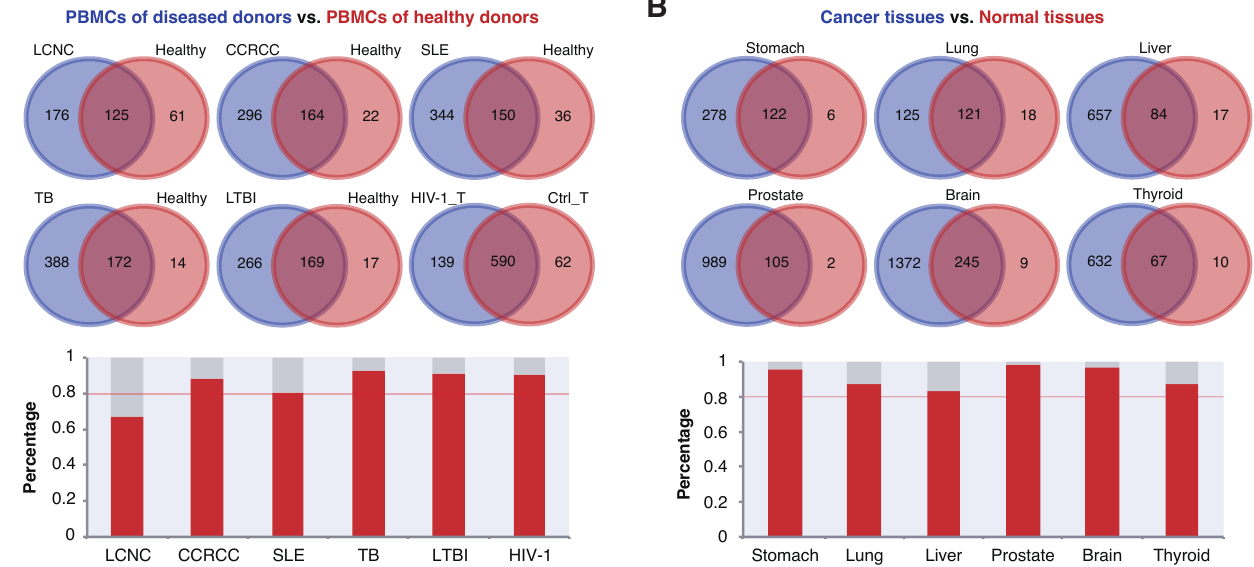
Figure 5. SEGs from tissues under stresses or with diseases. ( A ) Comparison of SEGs from PBMCs (or T cells for HIV-1 infection and control) of healthy donors and patients with diseases. ( B ) Comparison of SEGs from different healthy and diseased solid tissues. For both ( A , B ), the percentages of common SEGs (intersects of the Venn graphs) in healthy tissues were shown in the bar